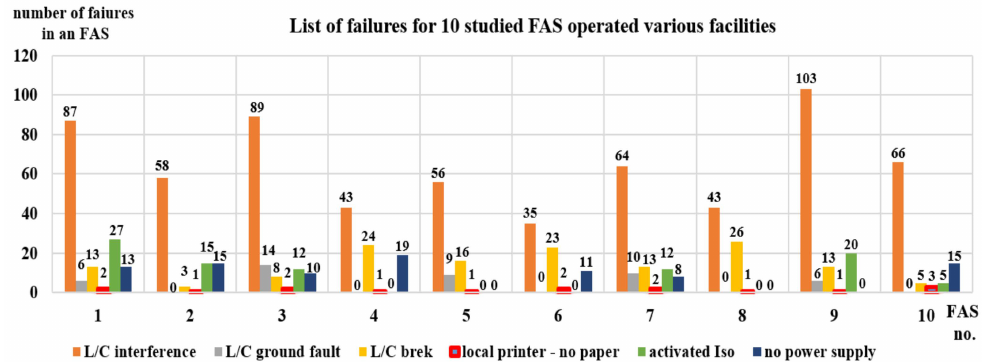
Figure 6. List of failures for 10 studied FAS operated in various facilities, where L—detection line, C—detection circuit, Iso—short-circuit isolator.